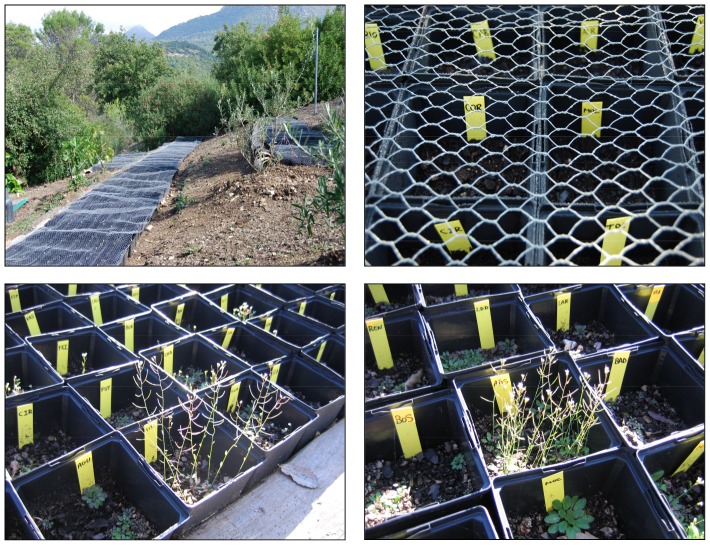
Photographs of the experimental setting at the El Castillejo Botanical Garden.Panels include a general view of the blocks and detailed views of pots with labels covered with the wire mesh, vegetative rosettes and fruiting plants of Arabidopsis thaliana.